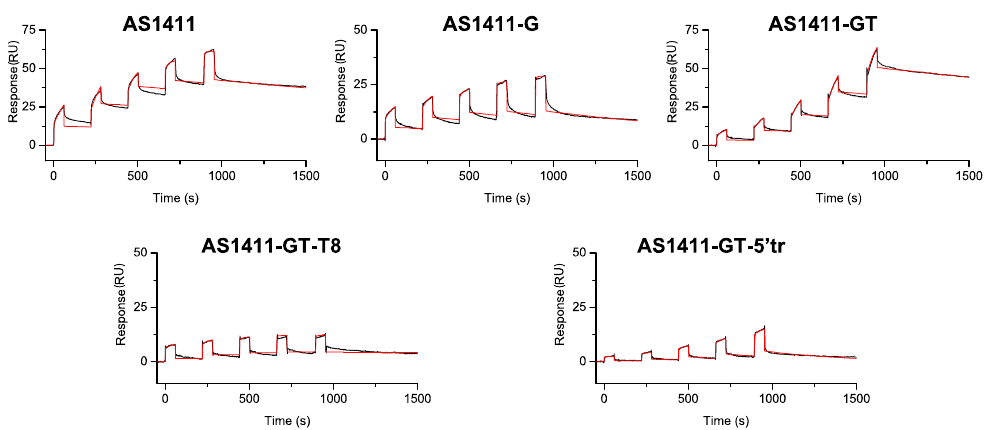
Figure 2. Time evolution SPR sensorgrams obtained at 25 °C by injections of various concentrations (from 2 to 32 µM) of each investigated GROs on the chip-immobilized nucleolin with a contact time of 60 s and a flow rate of 30 µL/min. The sensorgrams are shown as black lines and their respective fits as red lines.